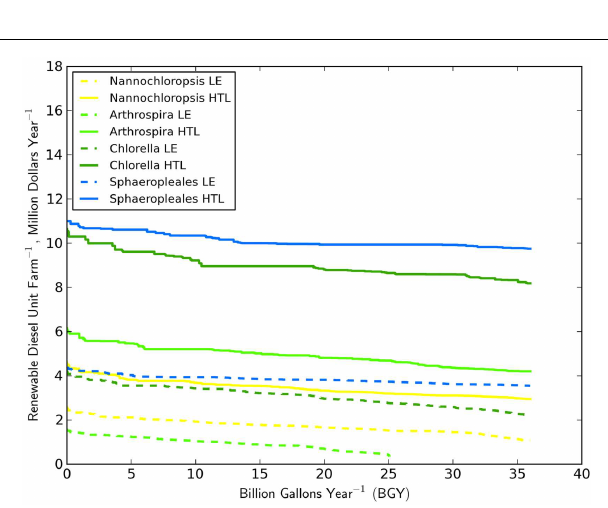
FIGURE 3 | Distribution of the value of RD per unit farm (405ha pond area) for the four strains and two biomass to biofuel processes studied .